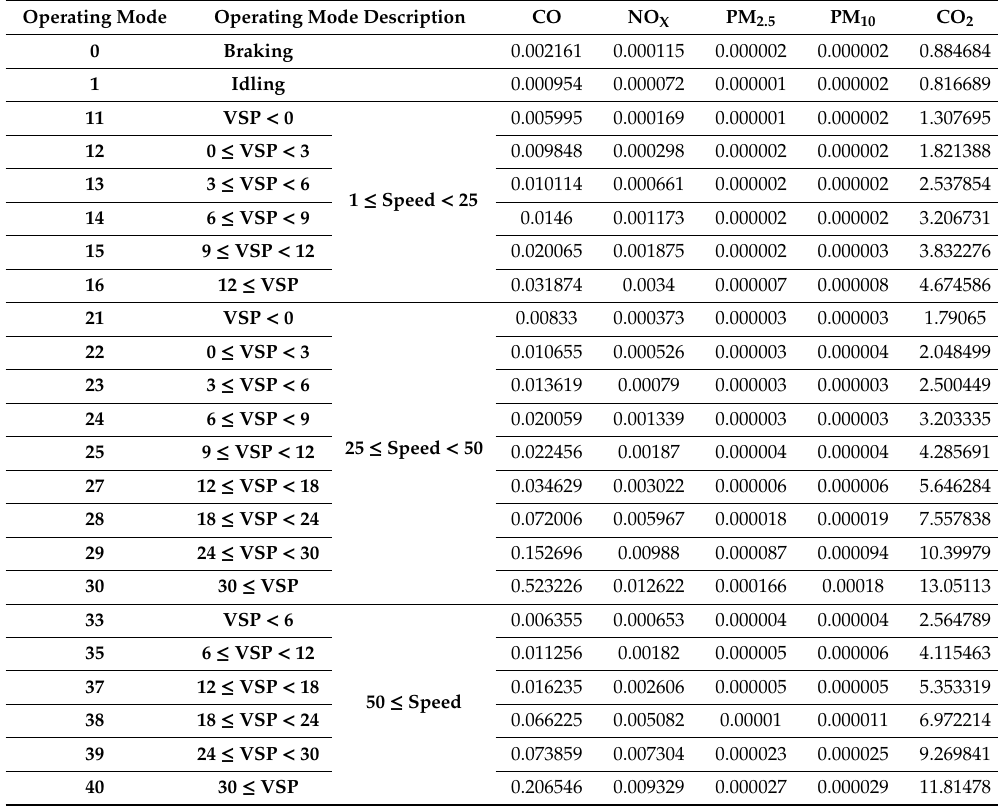
Table A1. Calculated Emission Rates (g / s) by OpMode for a Passenger Car in Gyeonggi-Do, Korea.